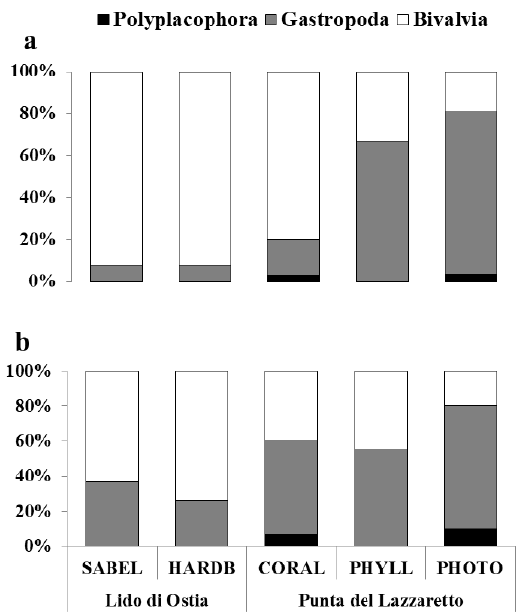
Figure 2. Percentages of abundance (%DI - a ) and species richness (%DQ - b ) of Polyplacophora, Gastropoda and Bivalvia for each habitat (SABEL ― S. alveolata reef; HARDB ― hard bottom with photophilic algae; CORAL ― coralligenous concretion; PHYLL ― P. crispa sciaphilic assemblage; PHOTO ― shallow photophilic assemblage) and site (Lido di Ostia; Punta del Lazzaretto).